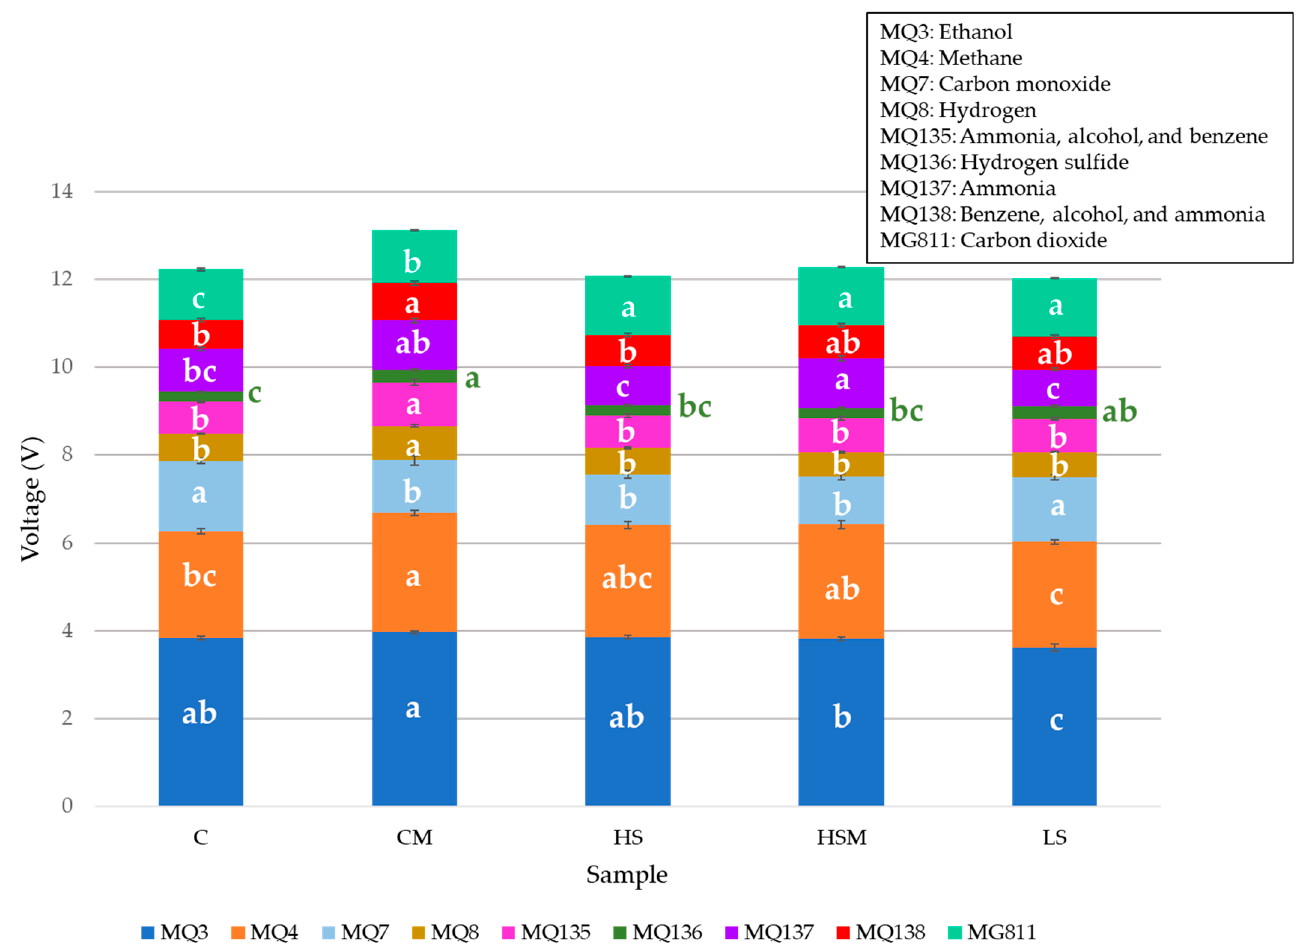
Figure 2. Mean stacked values of the electronic nose depicting the letters of significance from the ANOVA and Fisher least significant difference (LSD) post hoc test ( p < 0.05; α = 0.05). Abbreviations: C = control, CM = control with in-canopy misting, HS-high = density smoke exposure, HSM = high-density smoke exposure with in-canopy misting, LS = low-density smoke exposure.